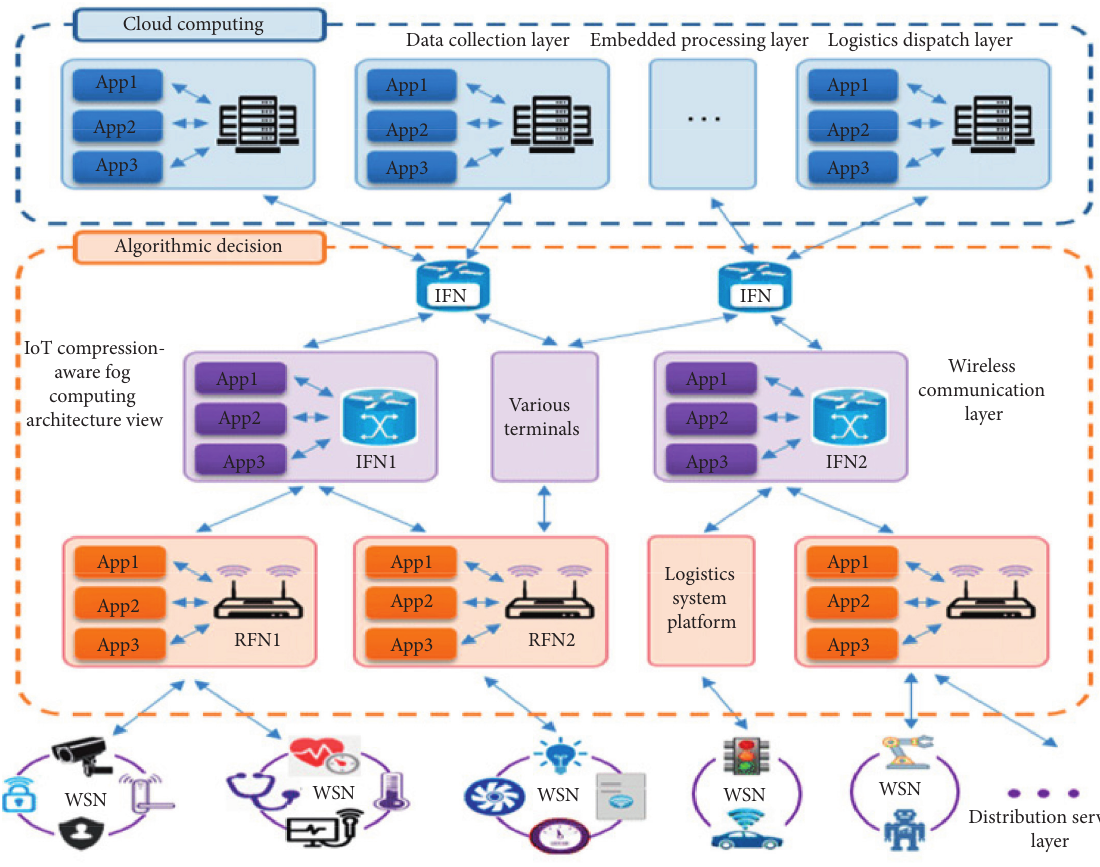
Figure 1: The overall structure of the intelligent coordination